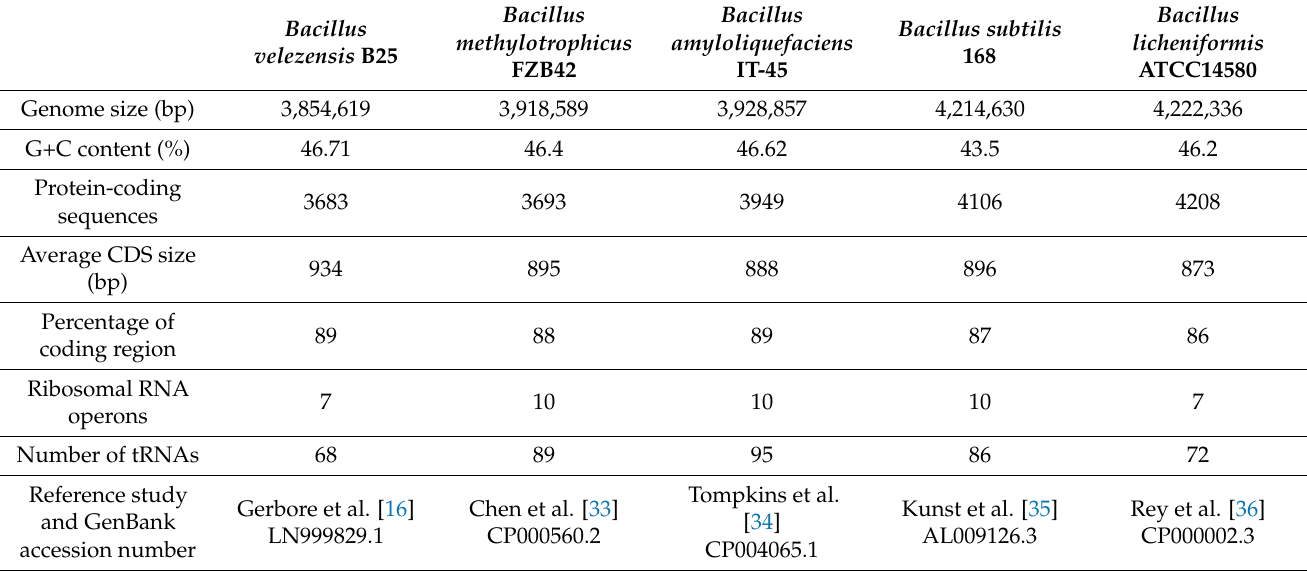
Table 1. Genomic features of Bacillus velezensis strain B25 and comparison with others Bacillus